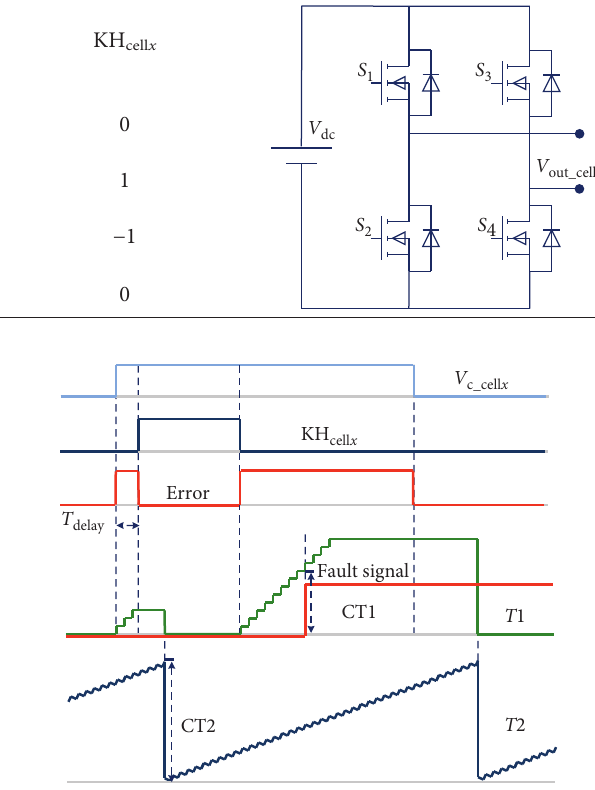
Figure 6: V c_cell x , KH cell x , fault signal, and T 1 and T